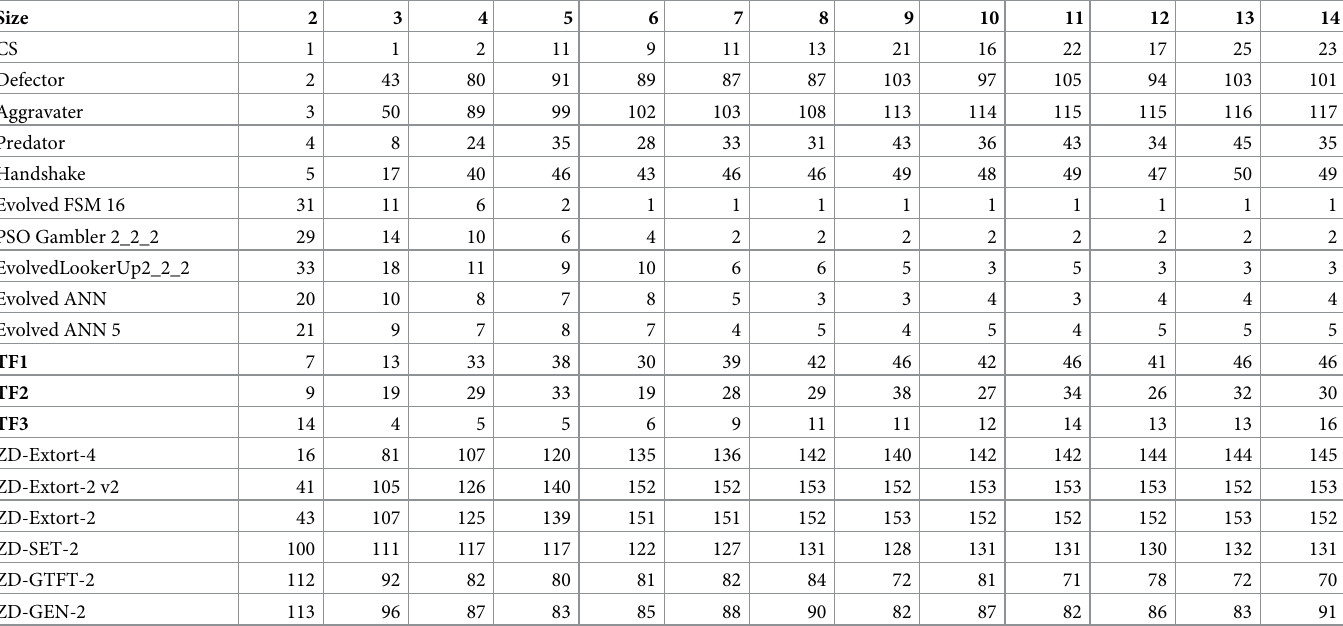
Table 11. Invasion: Fixation ranks of a few selected strategies according to x 1 for different population sizes. Size